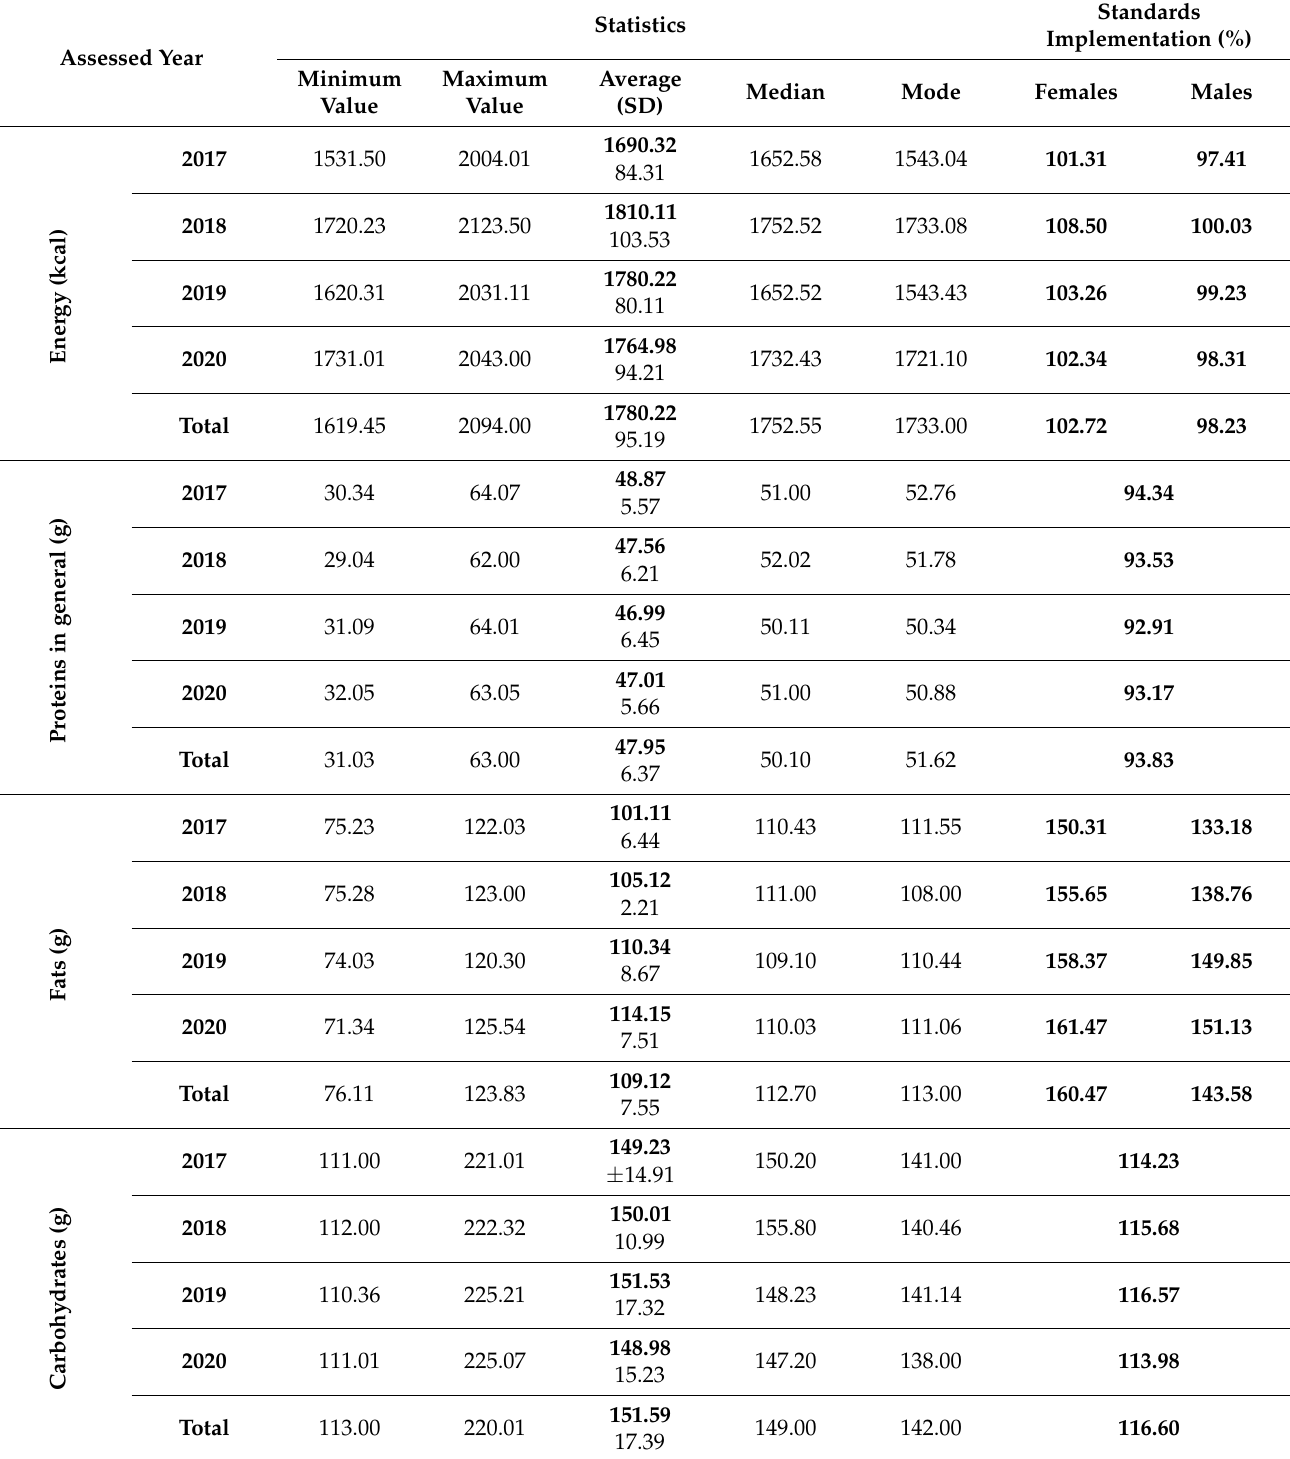
Table 2. Energy and nutrition value of assessed decade menus and standards